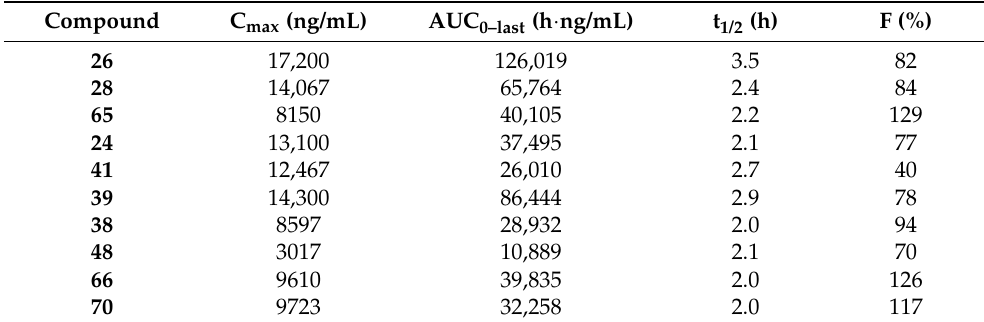
Table 5. In vivo pharmacokinetics (PK) properties of selected PERK inhibitors in mice. Compounds administered at 10 mg/kg by oral gavage (PO).